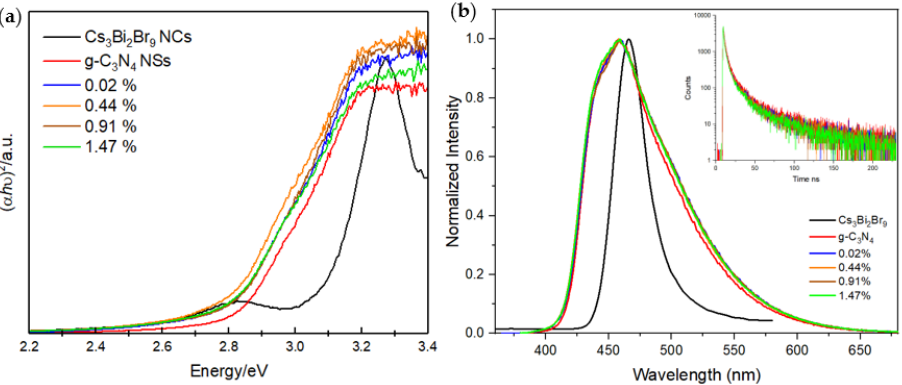
Figure 3. ( a ) Tauc plot and ( b ) normalised emission and time-resolved photoluminescence spectra of the g-C 3 N 4 NSs, the Cs 3 Bi 2 Br 9 NCs and the Cs 3 Bi 2 Br 9 NCs/g-C 3 N 4 NSs composites ( λ ex = 350 nm). The surface chemical composition was investigated via XPS analysis (Figure 4) of a representative sample (0.02 wt.%Cs 3 Bi 2 Br 9 /g-C 3 N 4 NSs). Figure S7 shows the survey spectra of the composite. Figure 4a shows the high-resolution spectrum of the C 1s. The spectrum is dominated by the characteristic peak at 288.2 eV originating from the sp 2 C atom connected to a N atom (N–C=N) from the aromatic ring of g-C 3 N 4 . The peak at 284.8 eV and 293.7 eV corresponds to C–C bonds (3.8% of the total C 1s) and the π - π * transition, respectively, with the latter being typical of aromatic carbon compounds. Figure 4b shows